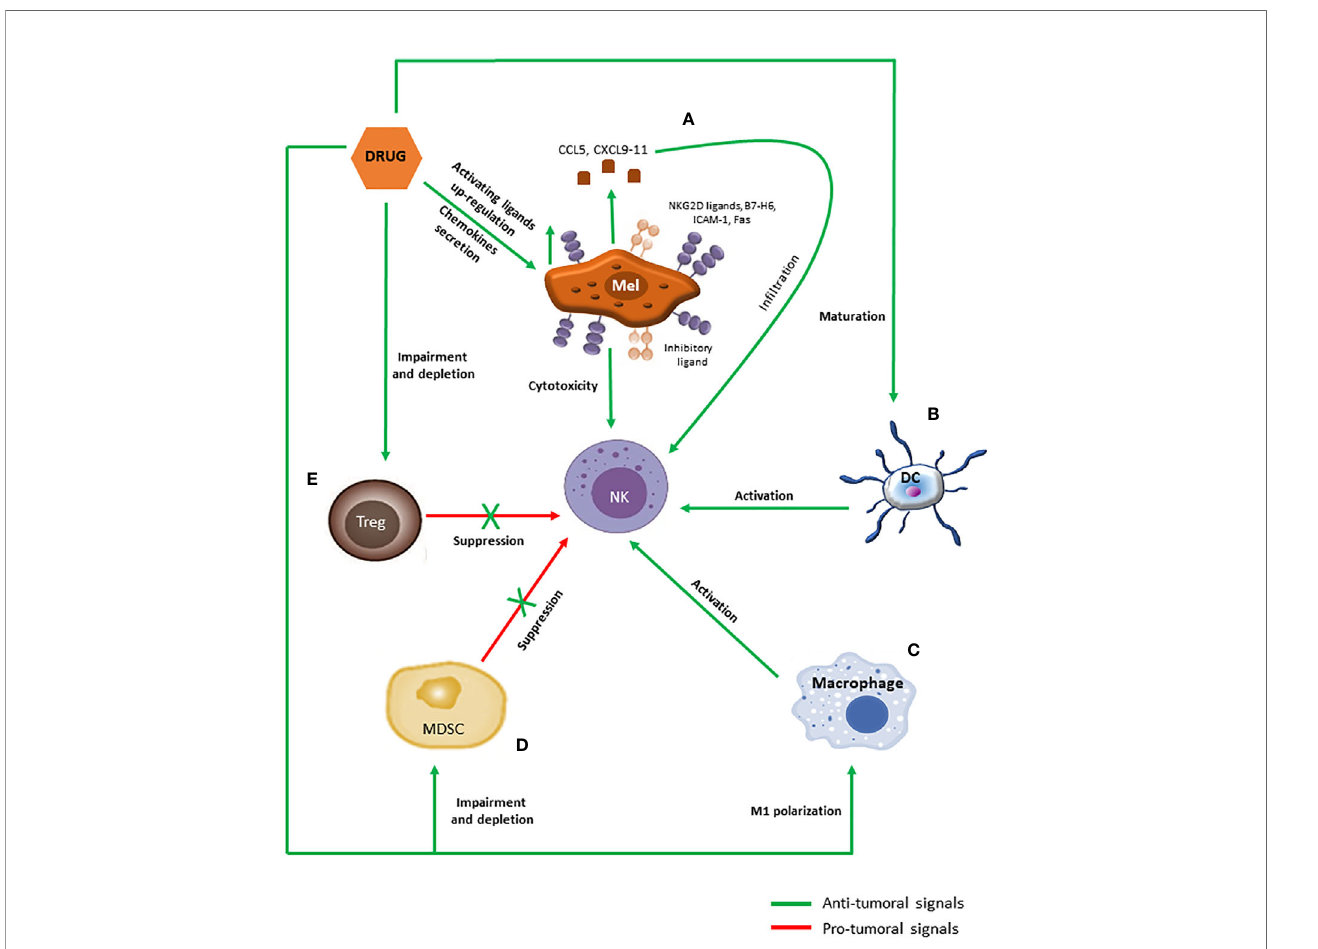
FIGURE 3 | Immunomodulatory effects of anti-melanoma chemotherapeutics promoting NK cells activation. (A) Chemotherapeutic drugs induce the secretion of CCL5 and CXCL9-11 chemokines by melanoma cells as well as the up-regulation of activating ligands on their surface, which in turn promote NK cells in fi ltration and activation, respectively. (B – E) Moreover, chemotherapeutic drugs promote maturation in DCs (B) and M1 polarization in macrophages (C) , which support NK cells functioning through cytokines secretion and cell-to-cell contacts, and blunt accumulation and functions of MDSCs (D) and Tregs (E) , counteracting their inhibitory effects against NK